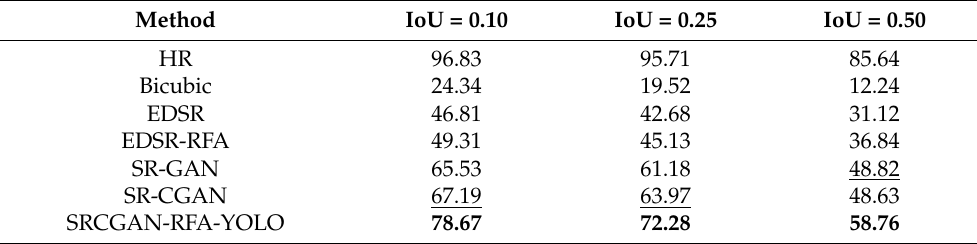
Table 8. Comparison of AP corresponding to different IoU for methods explored in this study (Bold = best results; Underline-second-best